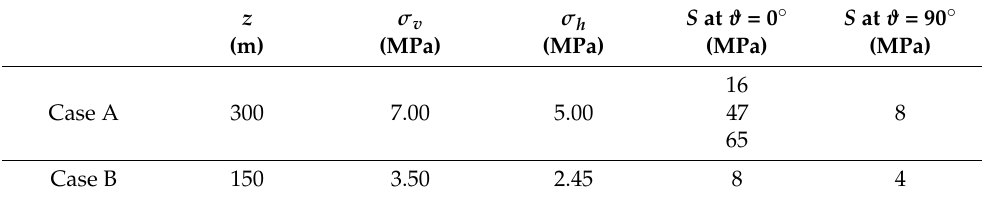
Table 2. Stresses used in the analysis of u lim . The factor K = 0.7 in both cases. Figure 4. Failure in the tension zone as a function of the induced state of stress. The dotted red lines are the failure planes.